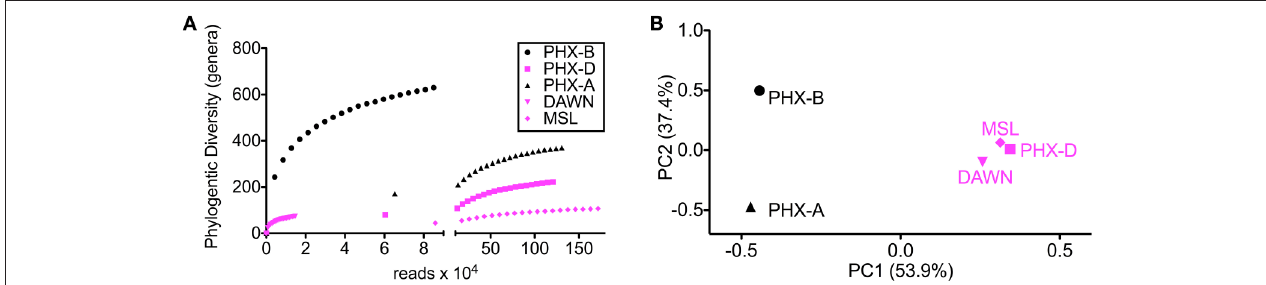
FIGURE 1 | Diversity is lower during assembly. (A) Rarefaction curves of samples taken during assembly (PHX-D, DAWN, MSL) show less genera at the same sample size compared to samples taken before (PHX-B) and after (PHX-A) assembly. (B) Principal coordinates analysis on genus taxonomic level based on a